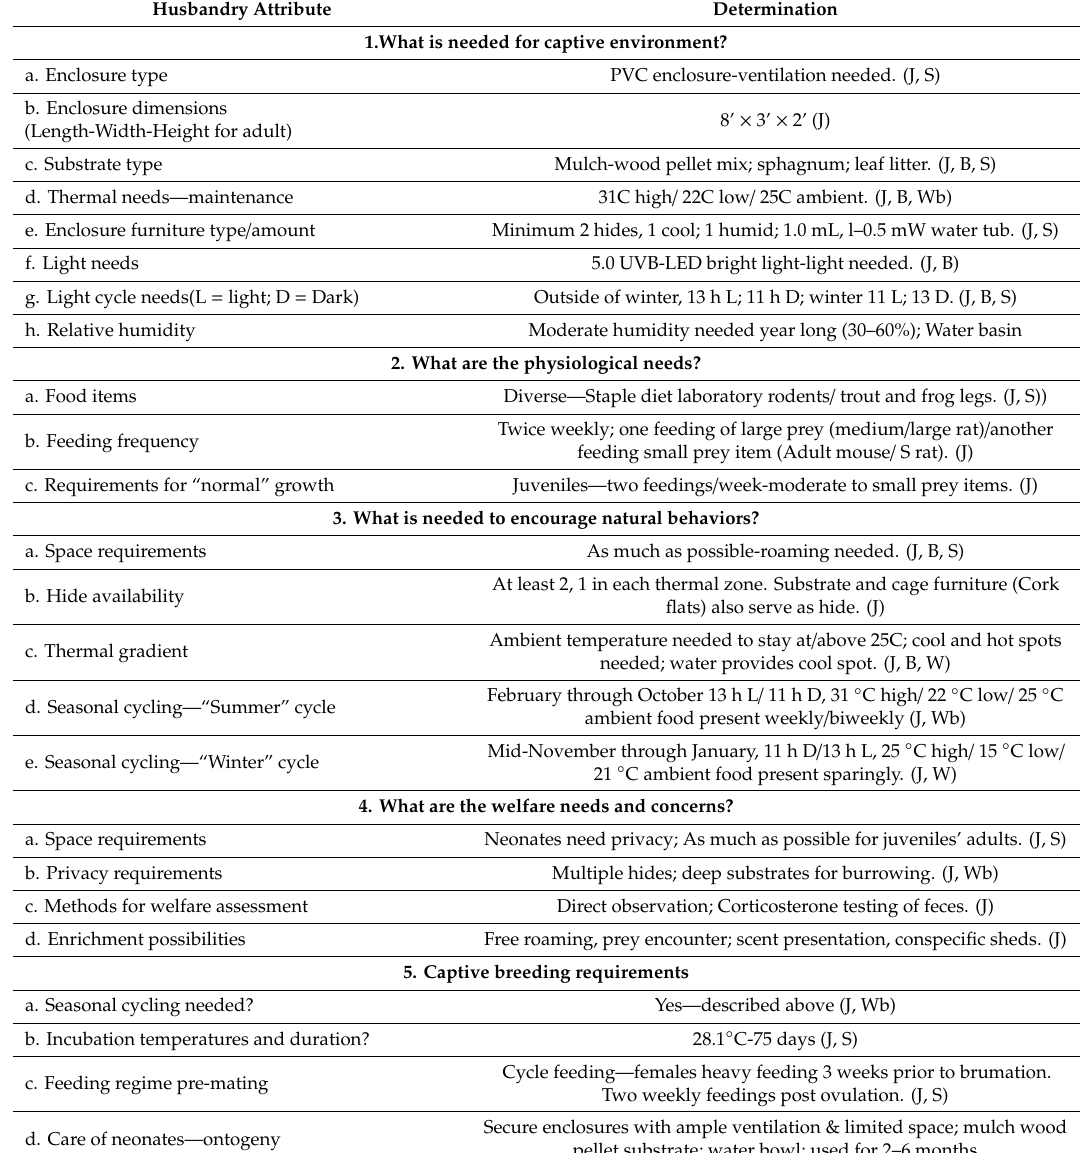
Table 4. Husbandry protocol for Hydrodynastes gigas using natural history information for its development. Justifications for each husbandry parameter are provided in the text. Parenthesis indicate source of informationusedforspecifichusbandryattribute. J = journalarticle; B = book / monograph; S = socialmedia; Wb =